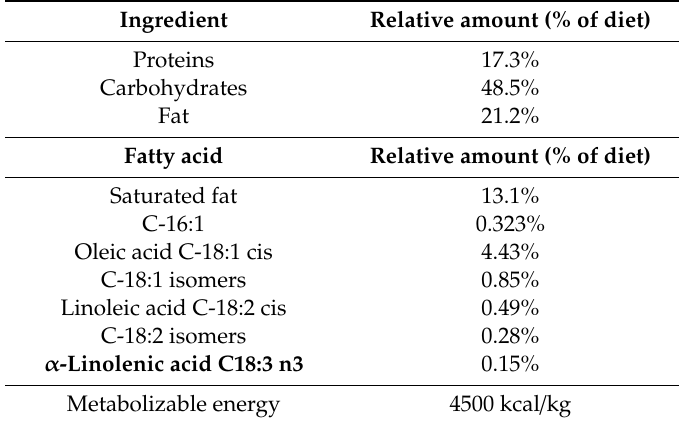
Table 2. Composition and fatty acid profile of the pro-inflammatory TD.88137 high-fat Western diet.